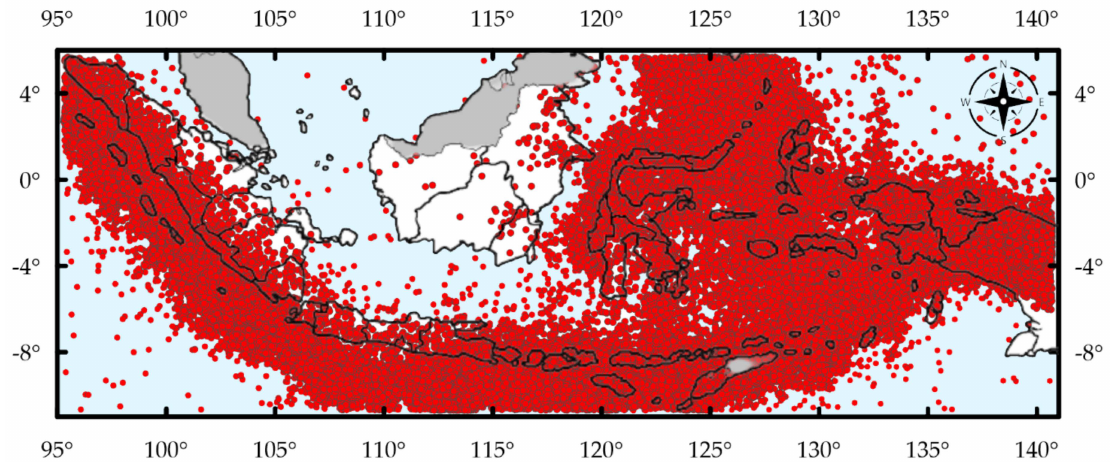
Figure 1. Epicenters of earthquakes in the compiled catalog for Indonesia.